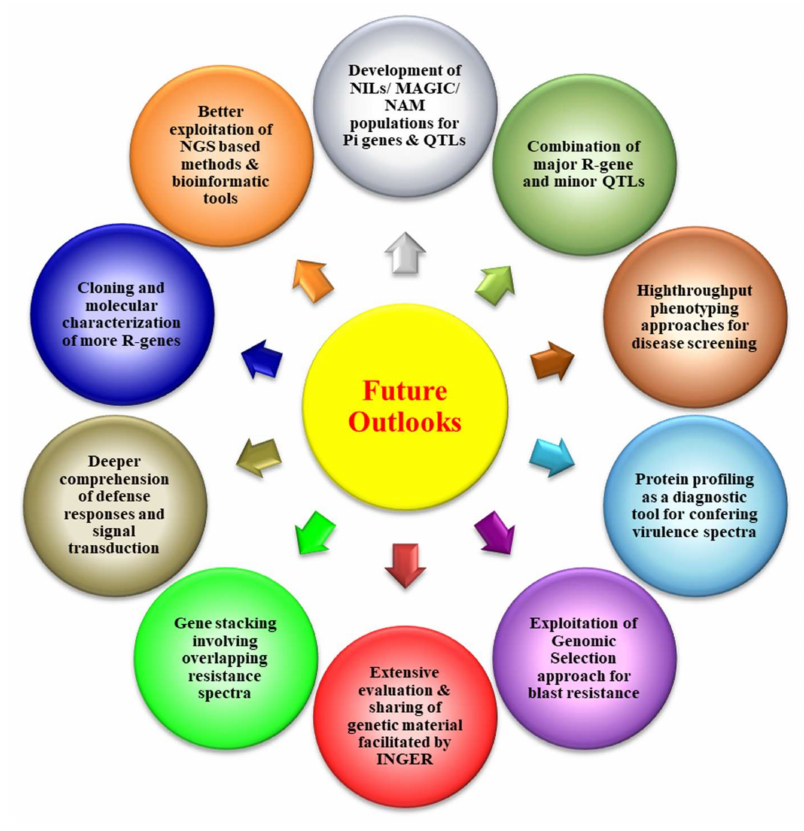
Figure 5. Future perspectives and way forward for developing blast resistance in